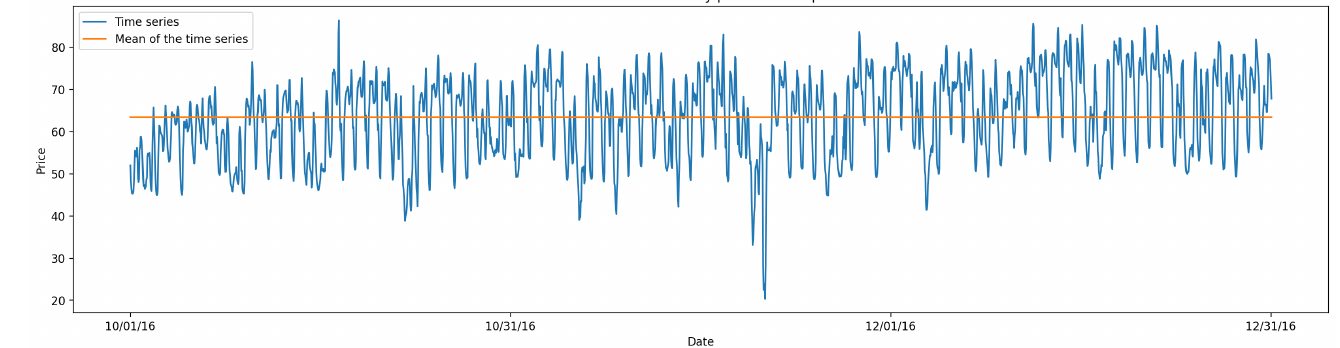
Figure 3. Time series of fraud period. On the x-axis we can see that this period covers electricity prices between October 2016 and January 2017, when the Fraud was reported. The horizontal line observed indicates the average for that period which is 63.46, a much higher value than the other periods in the study.